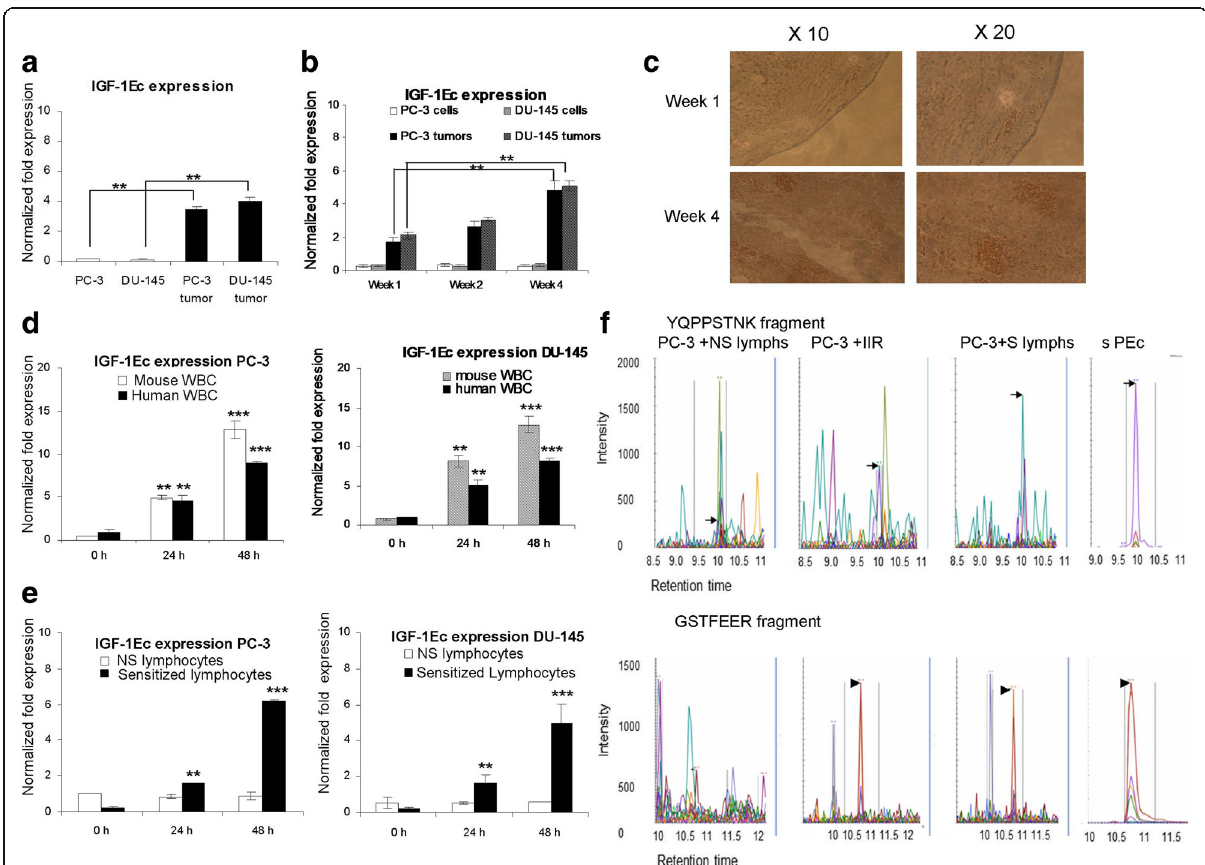
Fig. 1 PEc expression is induced in prostate cancer cells as a response to the immune system attack. a : Analysis of IGF-Ec expression in PC-3 and DU-145 cell lines and their corresponding tumors in SCID mice, by qRT-PCR. The PC-3 and the DU-145 tumors produced significantly higher IGF-1Ec expression when compared to their corresponding cell lines. b : Analysis of IGF-1Ec expression in PC-3 and DU-145 tumors (qRT-PCR) at different time intervals. In both cases IGF-1Ec expression is increased as tumor progresses. c : Detection of mouse CD-45 positive cells in human tumors extracted from SCID mice (IHC). A significant increase of CD-45 cells was observed as tumor progresses. d : Effect of the mouse and human cells of the IIR in the IGF-1Ec expression levels in PC-3 and DU-145 cells. In both cases human and mouse IR seems to be associated with significant IGF-1Ec upregulation in prostate cancer cells at 24 and 48 h. e : Co-incubation of PC-3and DU-145 cells with human sensitized lymphocytes indicated a significant increase of the IGF-1Ec expression at 48 h compared to the prostate cancer cells treated with non-sensitized lymphocytes. f : Multiple Reaction Monitoring (MRM) analysis of protein in the media obtained from co-cultures of PC-3 cells with human lymphocytes or with cells of the IIR. Both PEc specific digest products ( YQPPSTNK and GSTFEER ), were detected into the media of PC-3 cells after co incubation with either the human cells of the IIR (sample 2) or with sensitized lymphocytes (sample 3) (**: p <0.005, ***: p